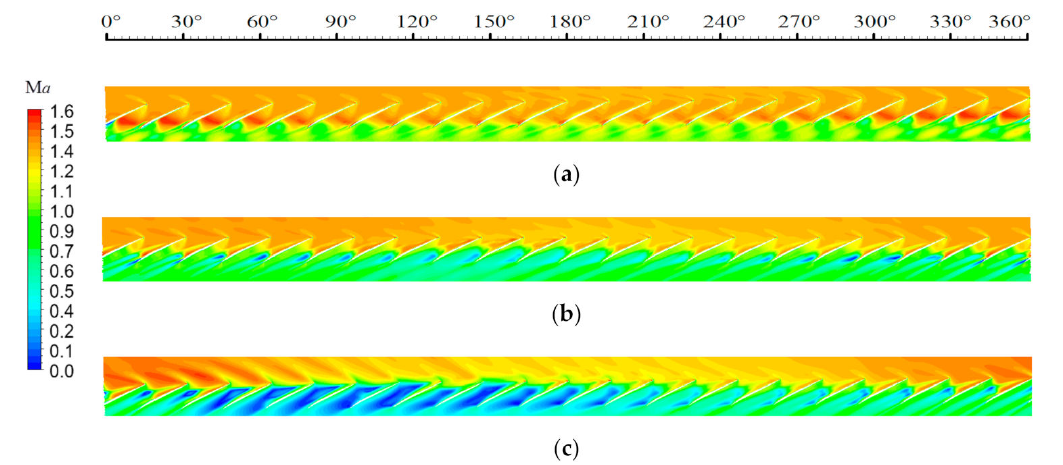
Figure 17. The circumferential distribution of the blade tip Mach number calculated by steady CFD under di ff erent working conditions at E = 160%. ( a ) NC; ( b ) NPE; ( c ) near stall